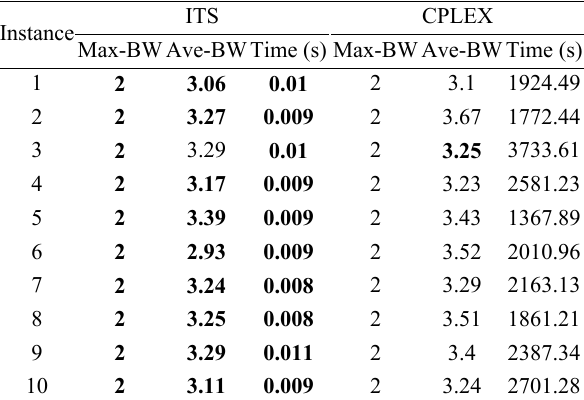
Table 3 Results of ITS and CPLEX for 10 instances ( m = 5).